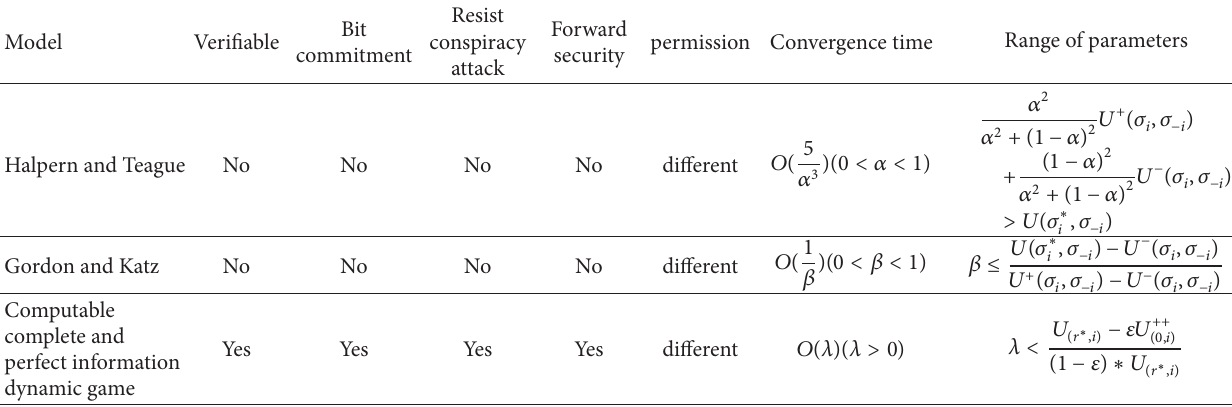
Table 1: Several models